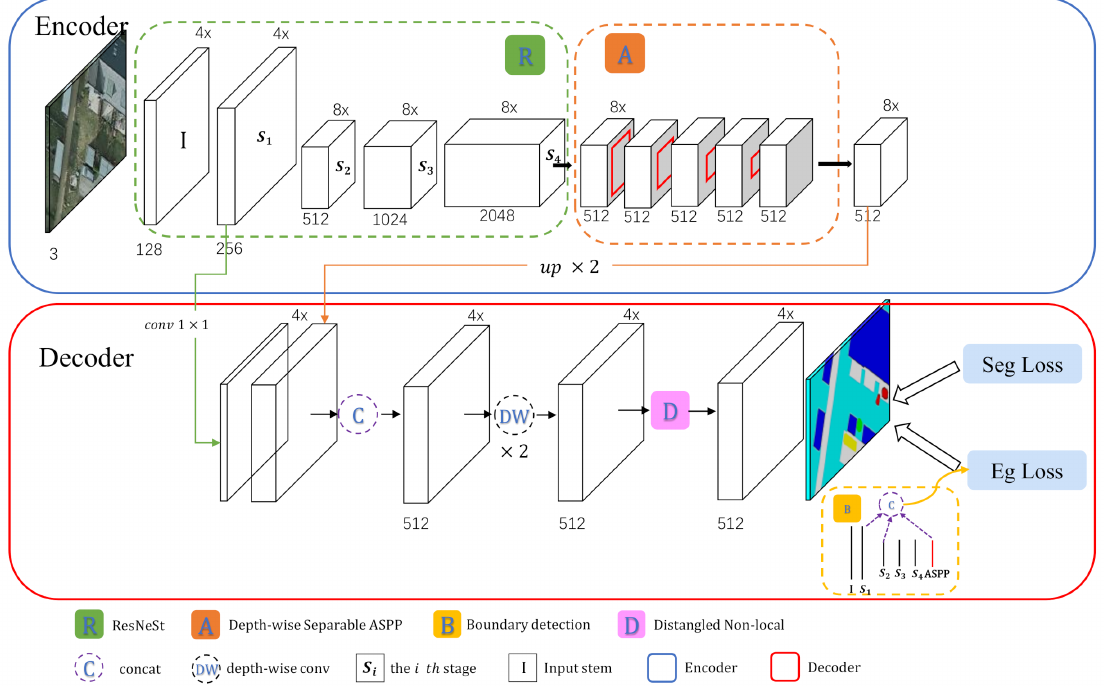
Figure 1. Pipeline of the proposed deep convolutional neural network for semantic segmentation of aerial